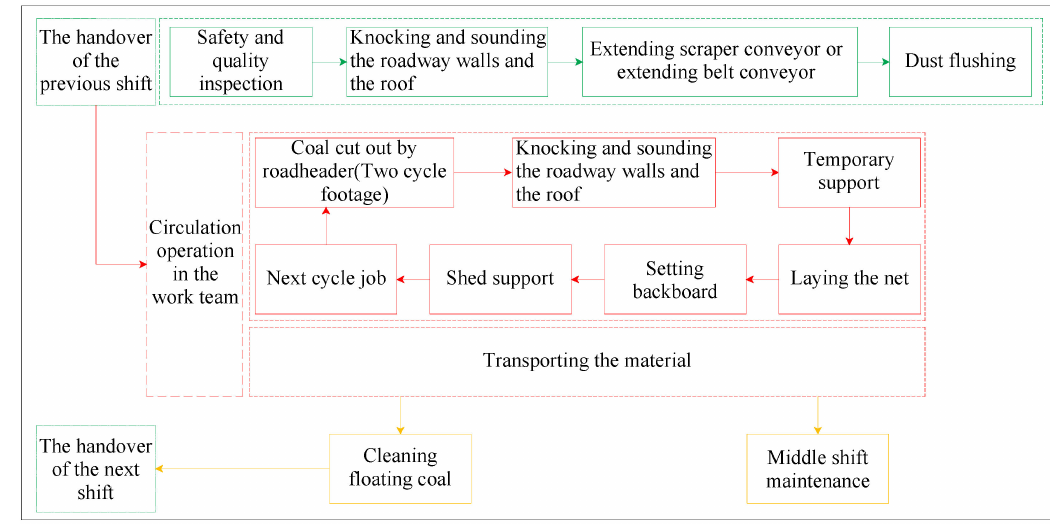
Figure 17. Optimized process flow